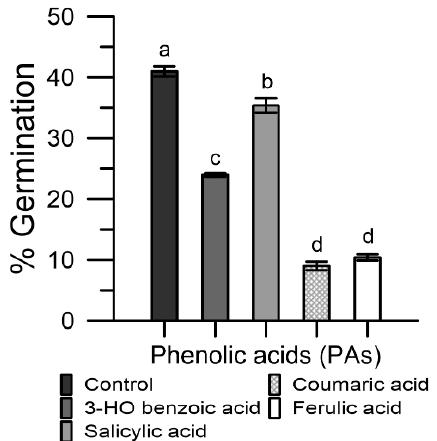
Figure 7. Germination of maize pollen grains in the presence of two hydroxybenzoic acids, sali- cylic and 3-HO benzoic, and two hydroxycinnamic acids, coumaric and ferulic. Data are expressed as means ± SEM. Different letters above bars indicate significant differences at p ≤ 0.05, whereas same letters indicate non-significant differences.